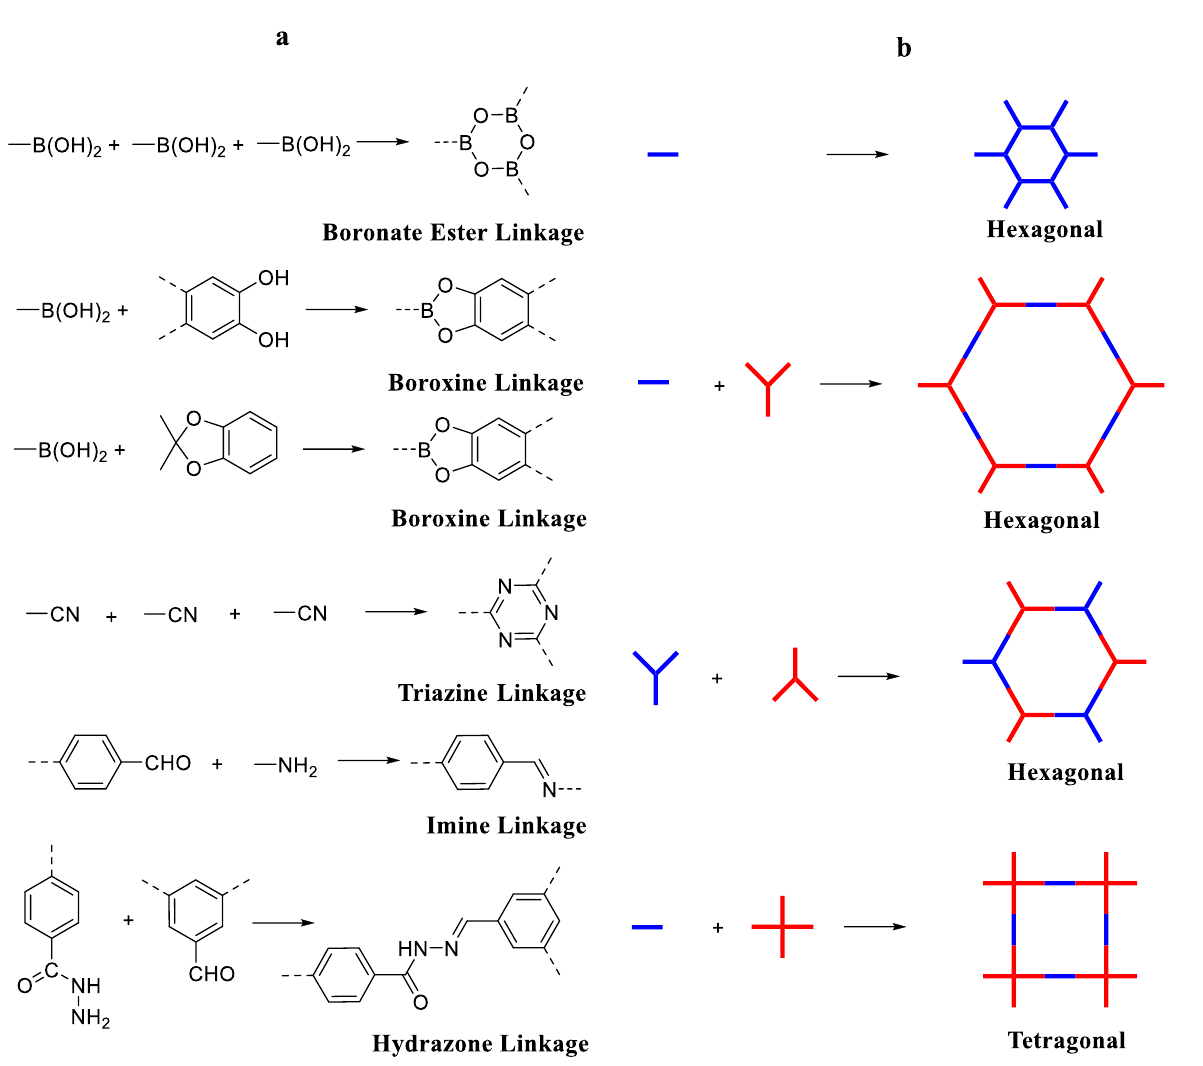
Figure 1. ( a ) Representation of chemical reactions for synthesis of COFs. ( b ) The combination of monomers to design 2D COFs.